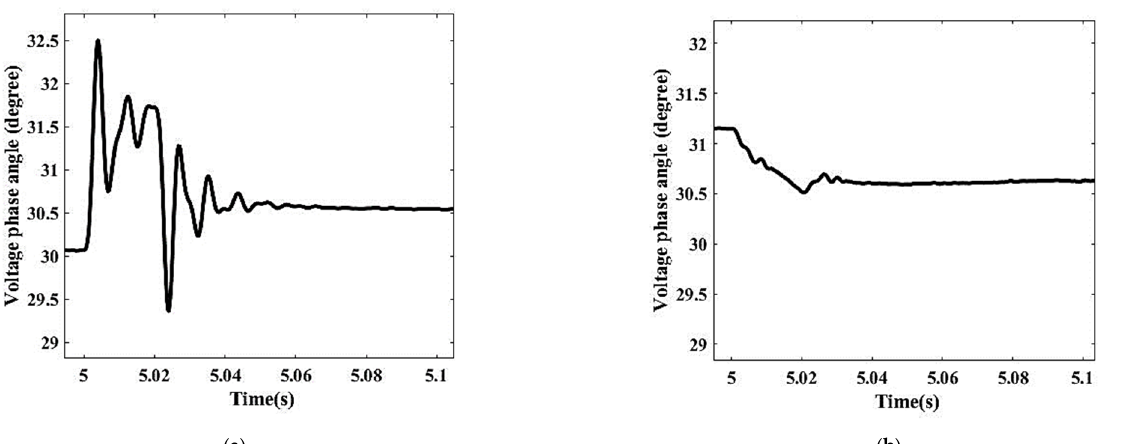
Figure 9. Magnitude of voltage phase angle during capacitor switching operations ( a ) Energization of a capacitor ( b ) De-energization of capacitor.